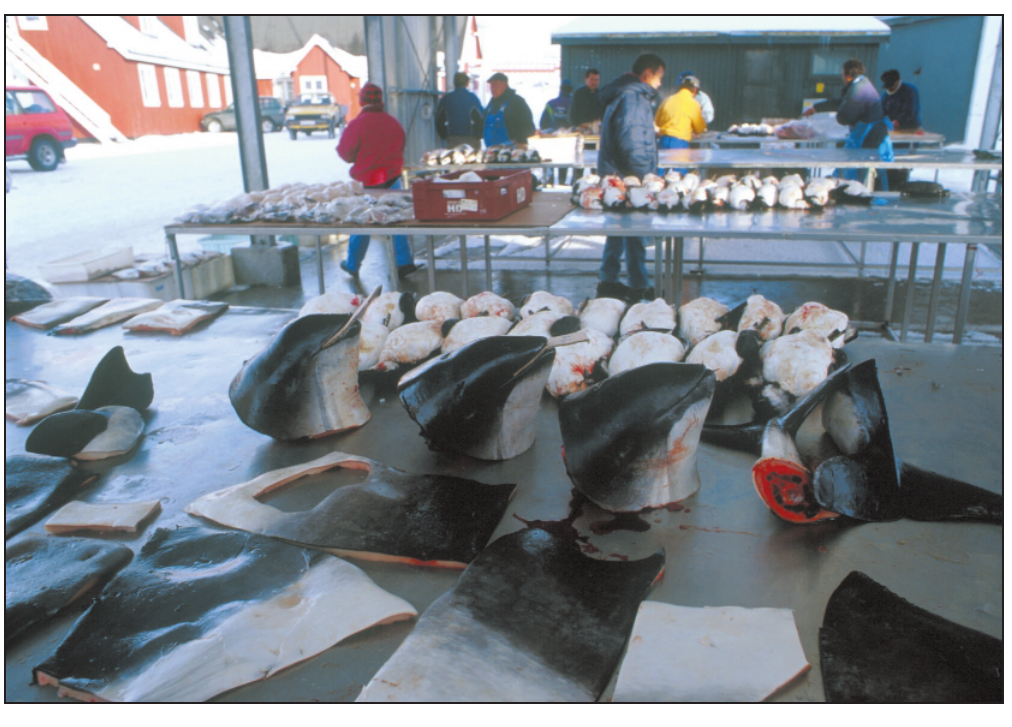
Fig. 1. Harbour porpoise meat, skin and heads are sold for food at a Greenlandic marketplace. (Photo: Lars